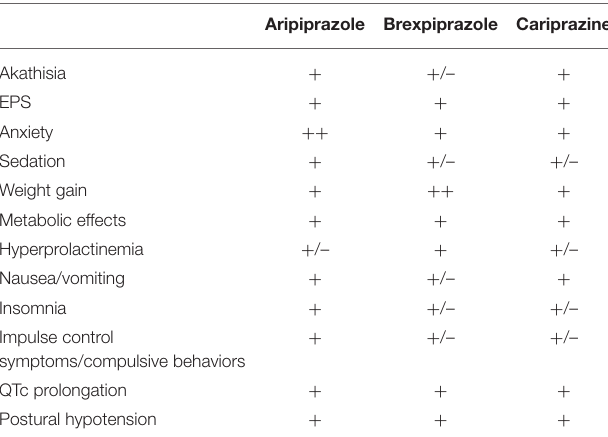
TABLE 7 | Overview of the clinical efficacy of dopamine receptor partial agonists